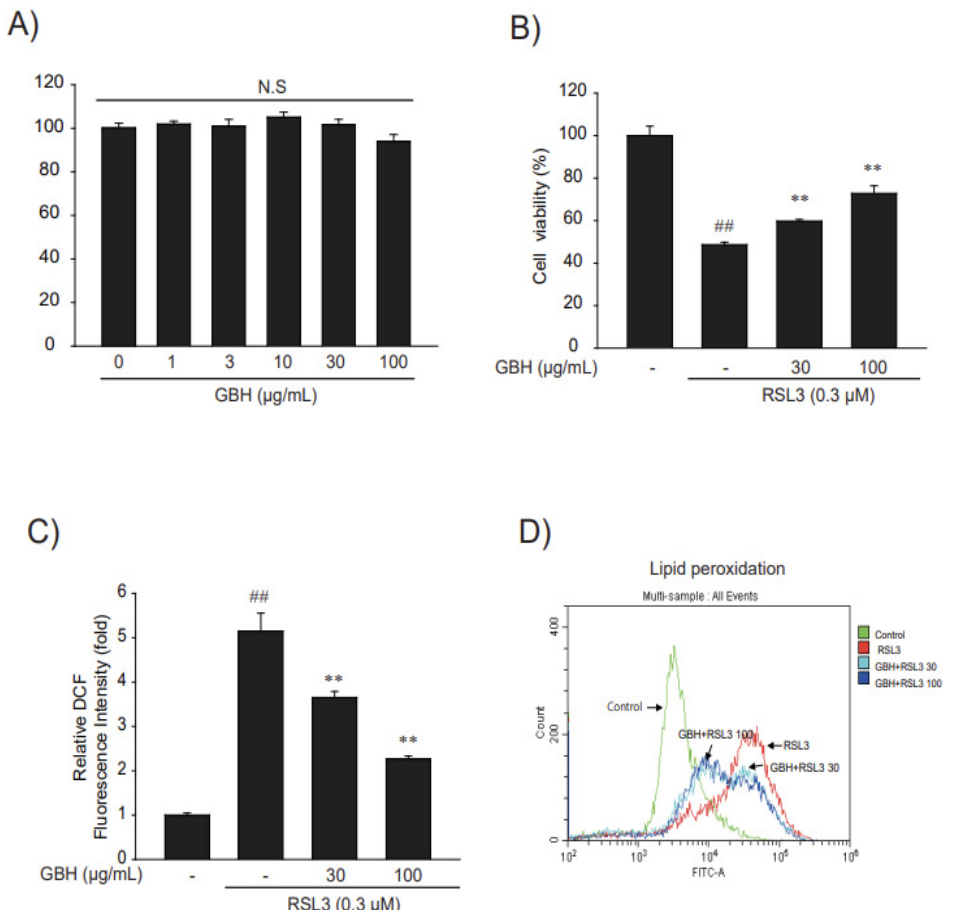
Figure 3. The cytoprotective efficacy of GBH in RSL3-induced HT22 cells. ( A ) The effect of GBH (1– 100 µ g/mL, 24 h) on the cytotoxicity of HT22 cells was estimated using MTT assay. ( B ) The efficacy of GBH on RSL3 induced cell death. Cells were treated with RSL3 (0.3 µ M) and/or 30–100 µ g/mL GBH for 6 h. Cell viability was assessed using the MTT assay. ( C ) The efficacy of GBH on RSL3-induced ROS production. The HT22 cells were pretreated with GBH for 1 h and incubated with 0.3 µ M RSL3 and/or 30–100 µ g/mL GBH for 1 h. Then, cells were stained with 10 µ M DCFH-DA at 37 ◦ C for 30 min. Intracellular fluorescence intensities were measured using a fluorescence microplate reader. ( D ) The efficacy of GBH on RSL3-induced lipid peroxidation. The HT22 cells were pretreated with GBH for 1 h and incubated with 0.3 µ M RSL3 and/or 30–100 µ g/mL GBH for 4 h. Then, cells were stained with 10 µ M C11-BODIPY for 1 h. The intensity of fluorescence in the cells was measured using flowcytometry (Beckman-Coulter). Data represent the mean ± S.E. of 3 experiments; ** p < 0.01, meaningful versus vehicle-treated control; ## p < 0.01, meaningful versus RSL3 alone.